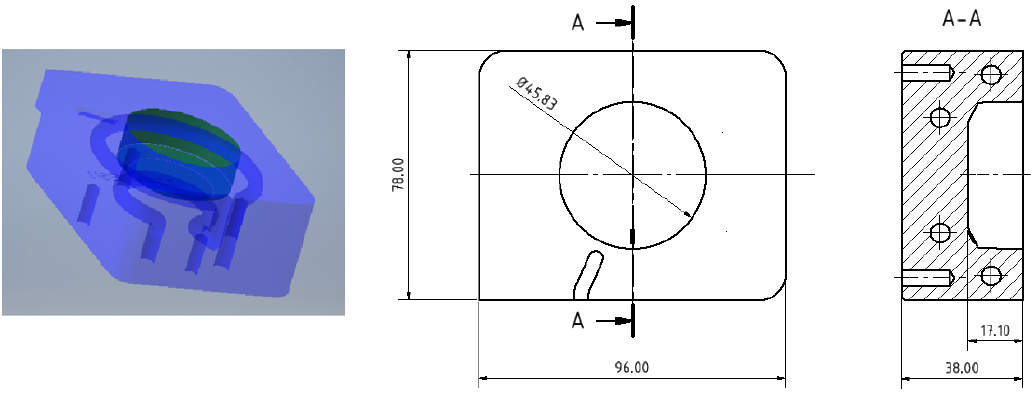
Figure 4. Shaped intermediate piece with conformal cooling. (unit: